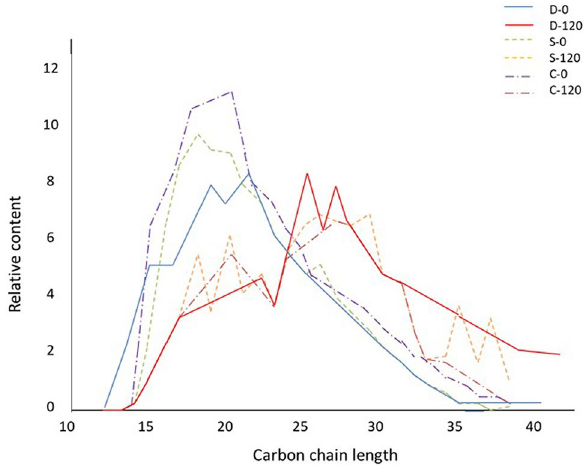
Figure 1. Relative content of n-alkanes with different C-chain lengths in the D, S, and C soil samples contaminated with 6% (l) and 25% (u)